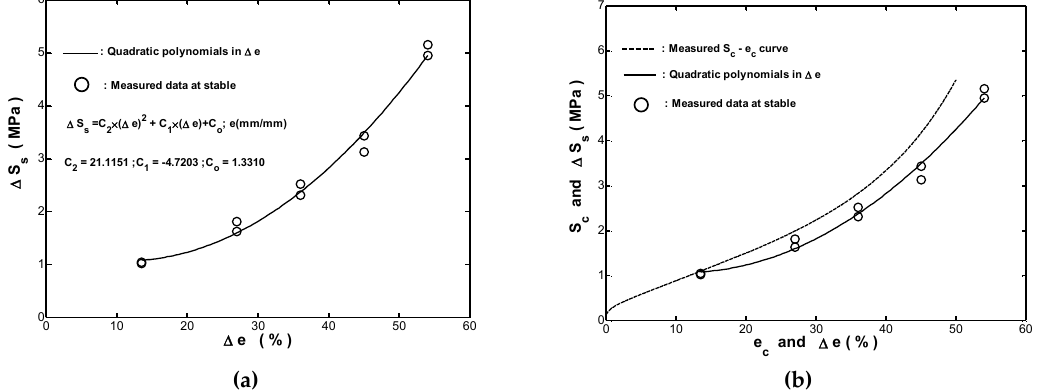
Figure 10. ( a ) Comparison of fitted ∆ S s − ∆ e curve and measured data ( ∆ e , ∆ S s ) for the ten-thousandth cycle of cyclic straining test performed with A e = − 1, and ( b ) comparison of measured S c − e c curve and fitted ∆ S s − ∆ e curve.